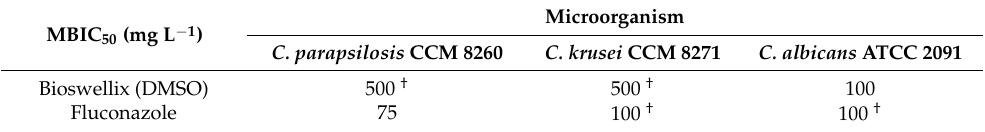
Table 2. Minimum biofilm inhibitor concentrations (MBIC 50 ) of Bioswellix and fluconazole for C. albicans ATCC 2091, C. parapsilosis CCM 8260 and C. krusei CCM